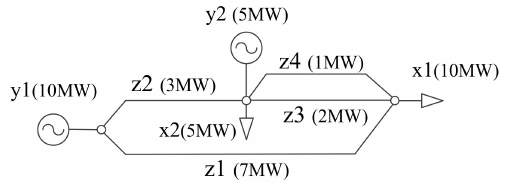
Figure 3. Three-bus system. The transmission paths obtained by PFT are shown in Table 2. Table 2. Transmission paths in three-bus system.